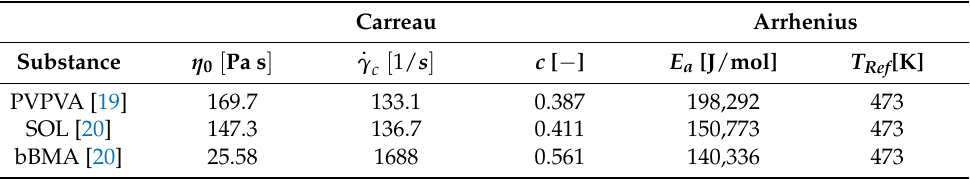
Table 1. Rheology parameters for the polymers based on a refit of literature data using Carreau– Arrhenius approach. Carreau Arrhenius . Substance η 0 [ Pa s ] γ c [ 1/ s ] c [ − ] E a [J / mol] T Ref [K] PVPVA [19] 169.7 133.1 0.387 198,292 473 SOL [20] 147.3 136.7 0.411 1688